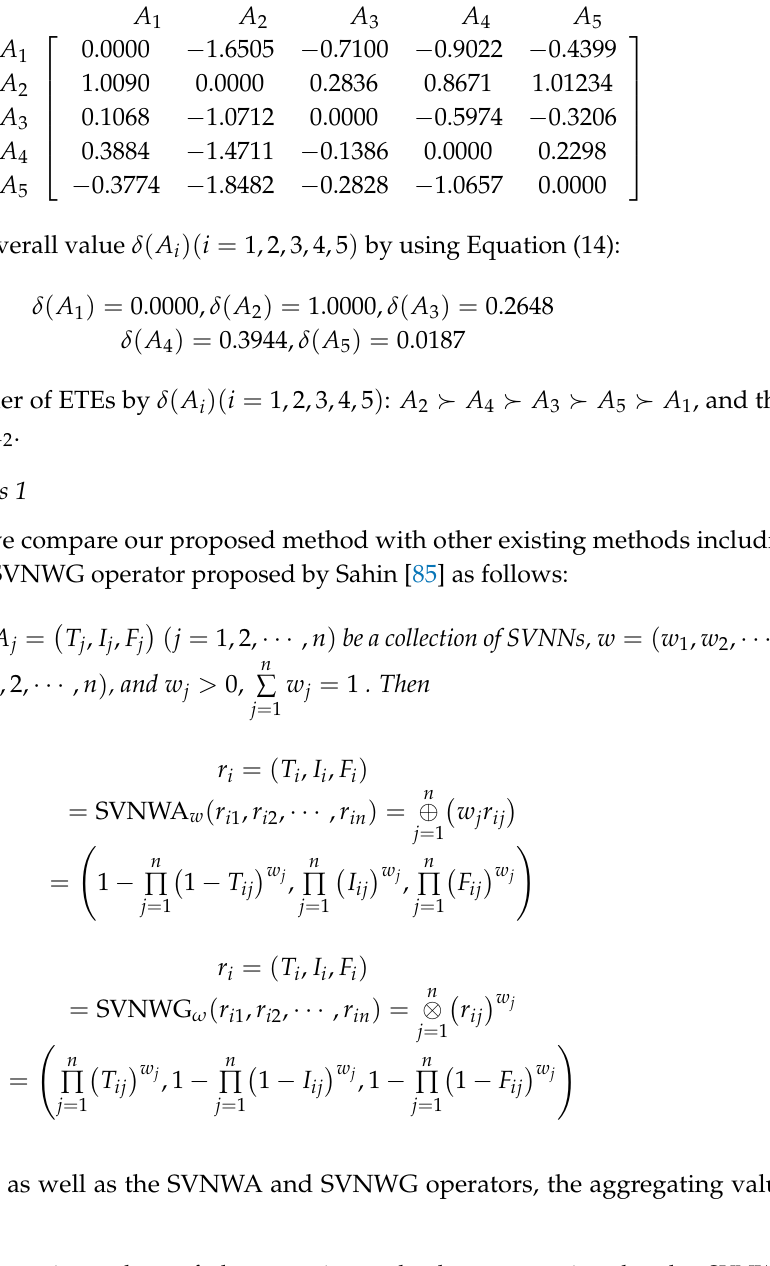
The aggregating values of the emerging technology enterprises by the SVNWA (SVNWG)